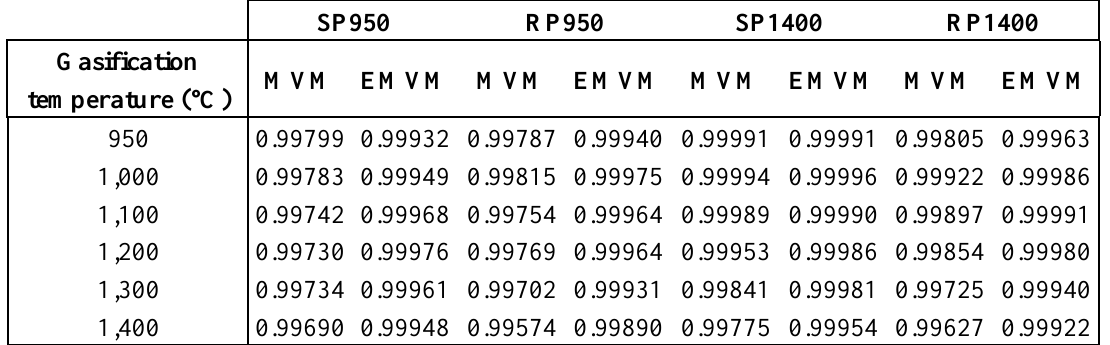
Table 2. Comparison of the square value of correlation index (R 2 ).